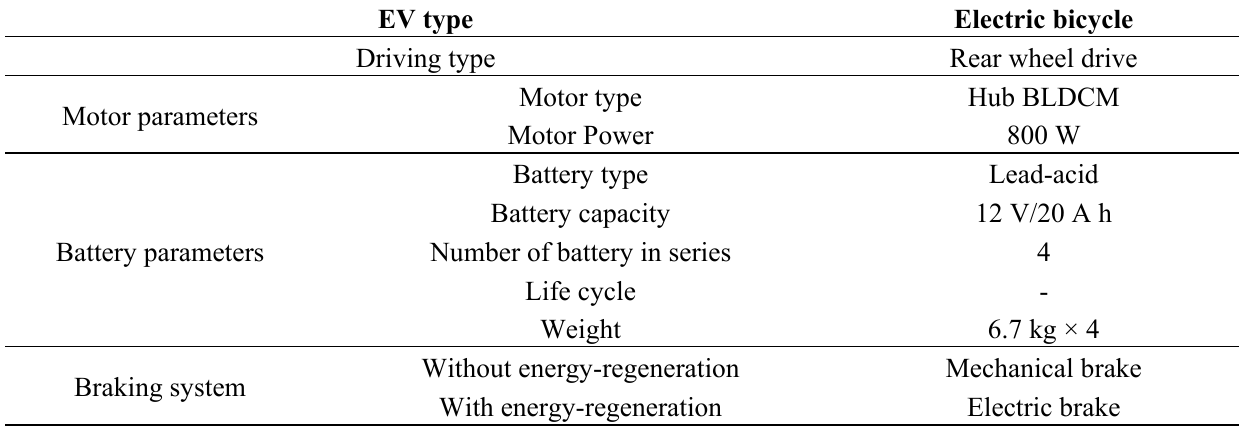
Table A1. Parameters and specifications used for